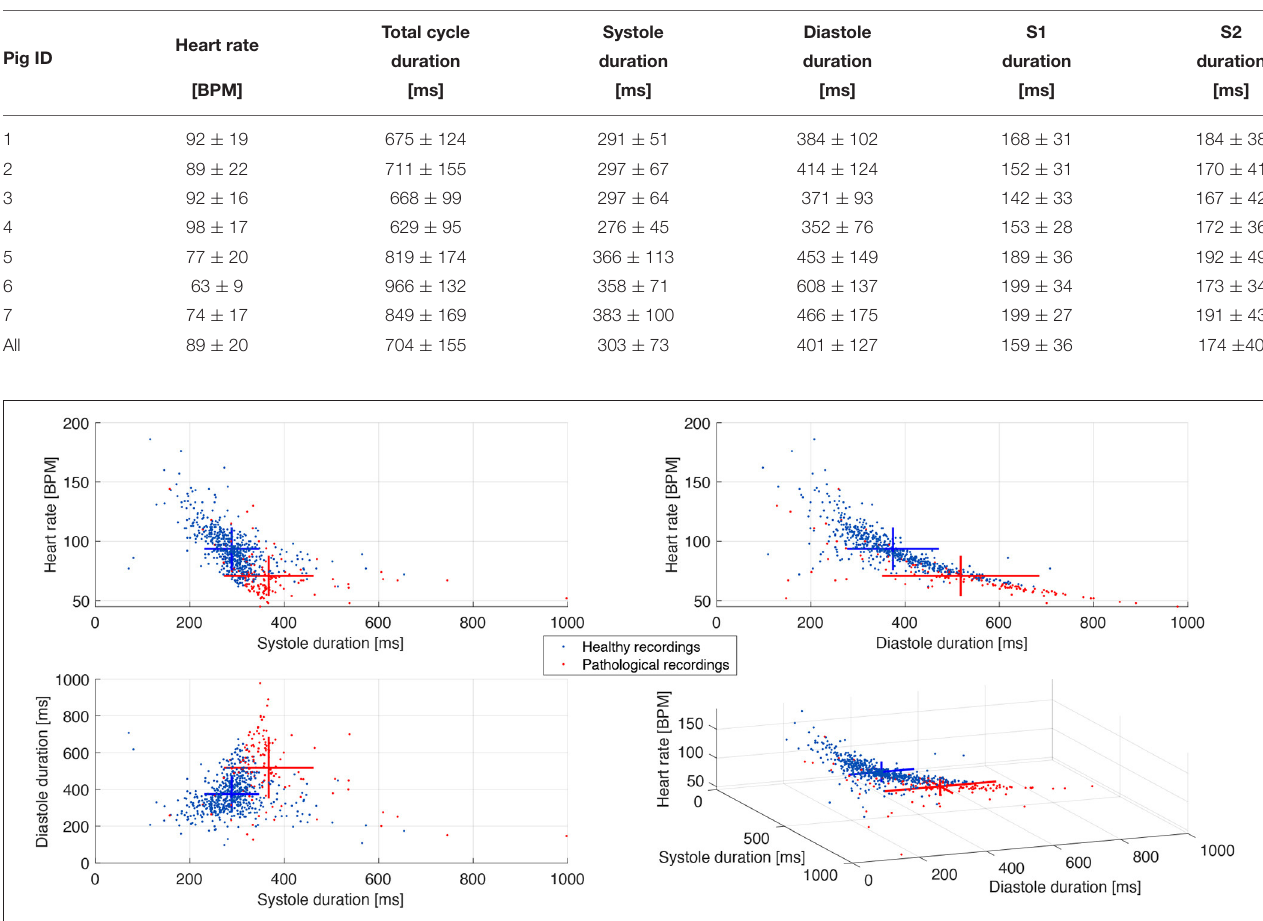
FIGURE 9 | Scatter plot of the cardiac cycle duration between healthy and pathological pigs. The crosses represent the mean and standard deviation of each population along the three